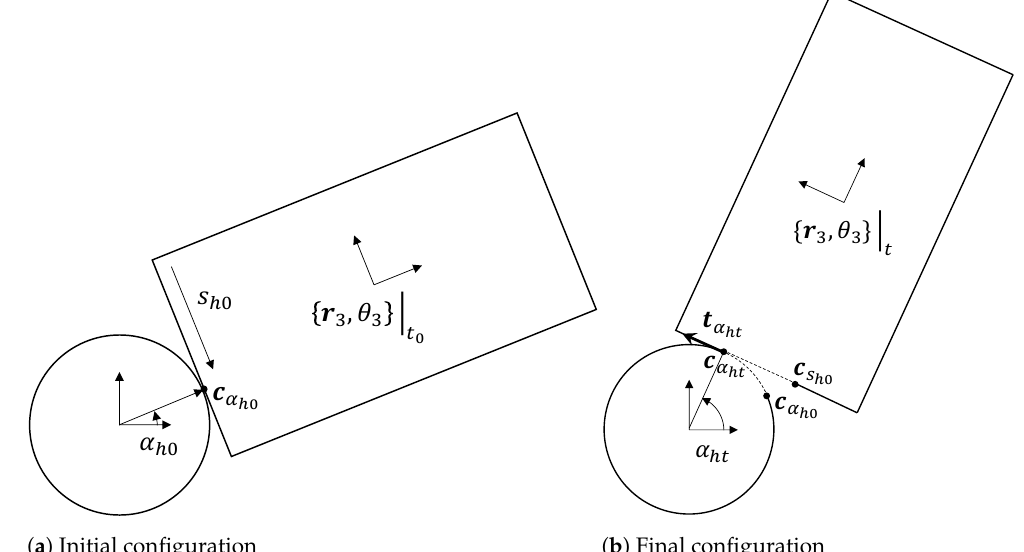
Figure 5. ( a ) Definition of initial hand − object configuration parameterized by α h 0 = α ∗ ( t 0 ) . ( b ) At time t , the object position and orientation can be obtained from ∆ α h = α ht − α h 0 . This follows from the rolling without slipping constraint that the distance traversed between c α hand boundary) should be equal and opposite to that traversed on the object boundary, i.e., from c s to c s ht